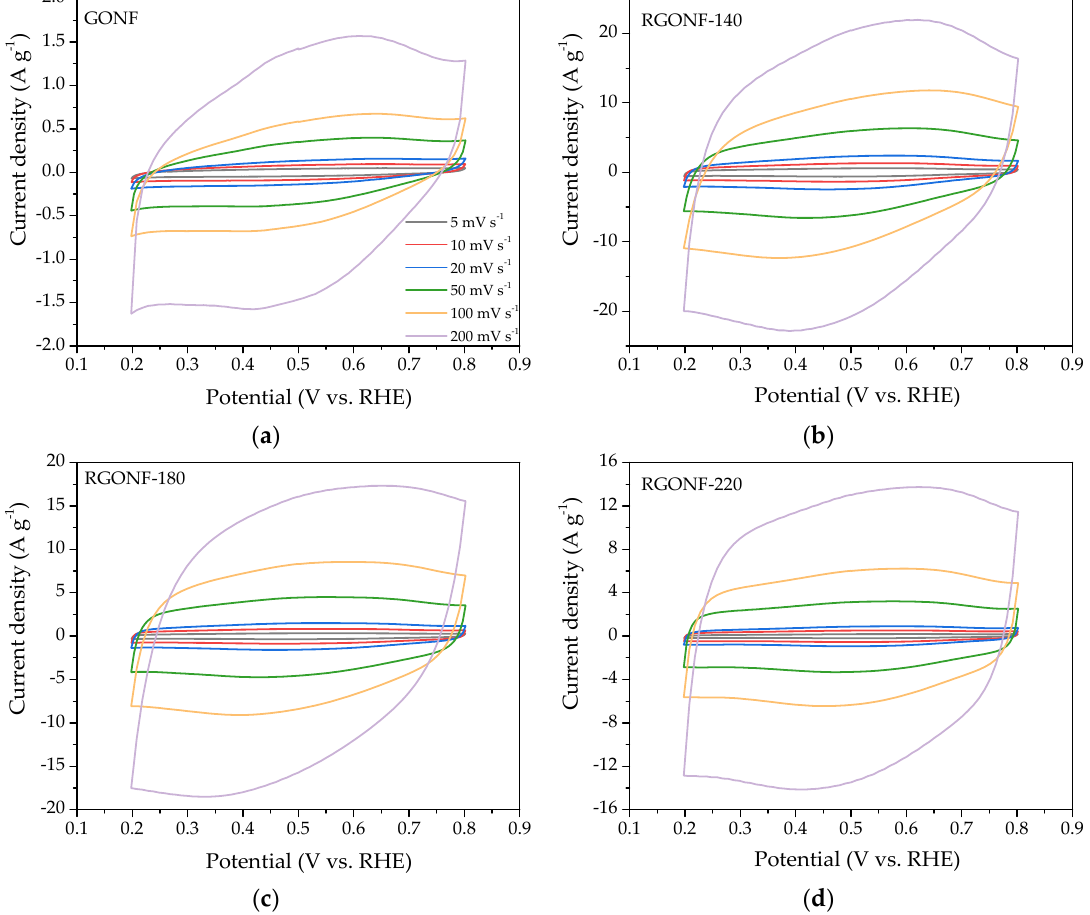
Figure 5. Cyclic voltammograms (CV) from 0.2 to 0.8 V vs. reversible hydrogen electrode (RHE) at several scan rates (5, 10, 20, 50, 100, and 200 mV · s − 1 ) of ( a ) GONF; and RGONFs obtained at ( b ) 140; ( c ) 180; and ( d ) 220 °C. Aqueous electrolyte: 0.5 M H 2 SO 4 .